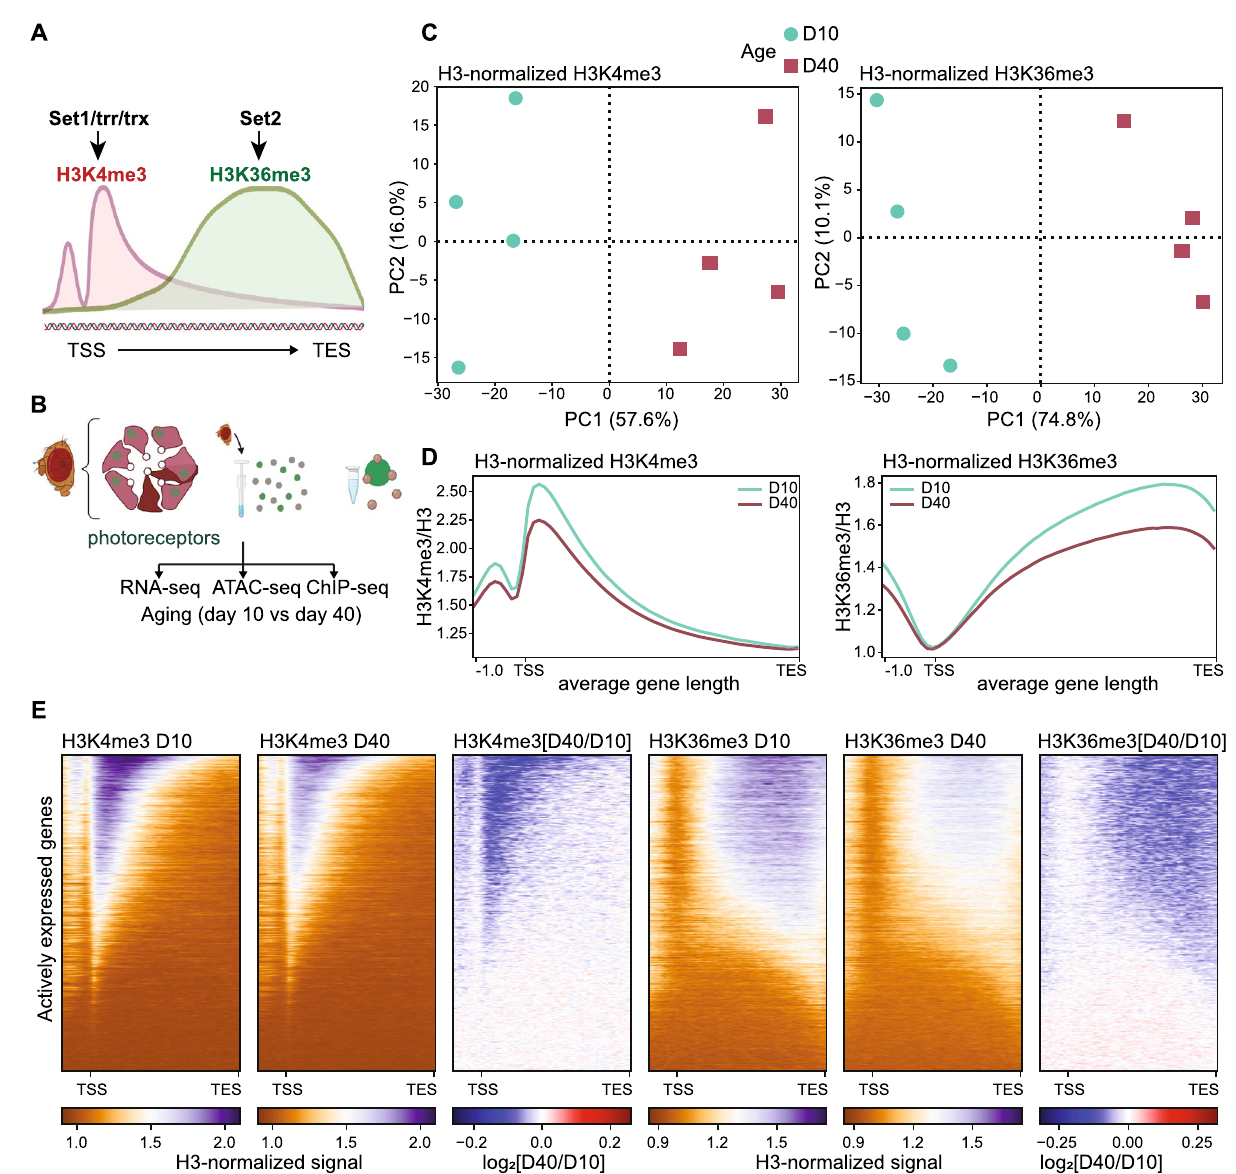
Figure 1. The active histone methylation landscape changes with age in photoreceptor neurons. ( A ) Diagram of the spatial distribution of active histone methylations around the gene body. In Drosophila, H3K4me3 is deposited by three enzymes (Set1, trr, trx), while H3K36me3 is deposited by Set2. TSS, transcription start site; TES, transcription end site. ( B ) Experimental diagram of nuclei immuno-enrichment protocol to purify aging photoreceptor nuclei. ChIP-seq analysis from the current study was integrated with RNA-seq and ATAC-seq from aging photoreceptors described in previously published studies. ( C ) Principal component analysis (PCA) H3- and CPM-normalized H3K4me3 (left) and H3K36me3 (right) (n = 4; D10, day 10; D40, day 40). ( D ) Gene metaplot of the average H3- and CPM-normalized H3K4me3 (left) and H3K36me3 (right) signal over gene bodies for young and old flies (n = 4). ( E ) Heatmaps showing H3- and CPM-normalized signal for H3K4me3 or H3K36me3 at D10 and D40 at all actively expressed genes (blue-orange heatmaps, panels 1–2 and 4–5). Ratios (log 2 ) of H3K4me3 or H3K36me3 changes between D10 and D40 are shown in the blue-red heatmaps in panels 3 and 6, representing the fold change signal in old relative to young flies with red indicating increase in active histone levels, and blue representing a decrease; no change is centered to